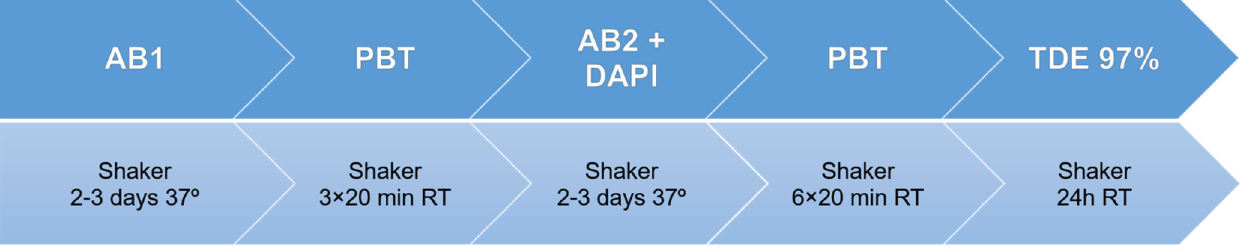
Figure 4. 2,3-thiodiethanol (TDE) clearing and IHC staining protocol.